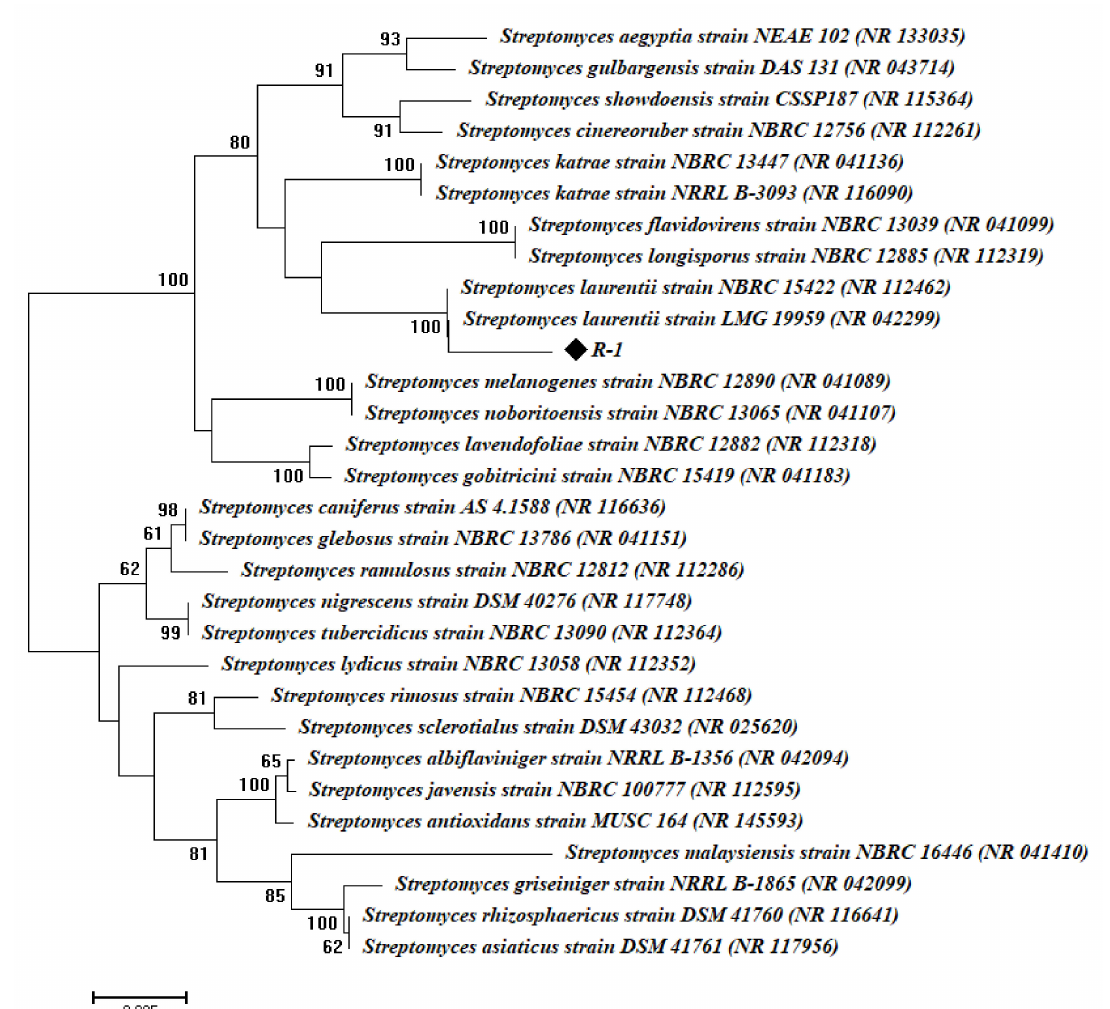
Figure 1. Phylogenetic tree of endophytic actinomycetes strain based on the 16S rRNA sequences analysis. Symbol (cid:117) indicates 16S rRNA fragments obtained from the current study. The analysis was completed with MEGA 6 using the neighbor-joining